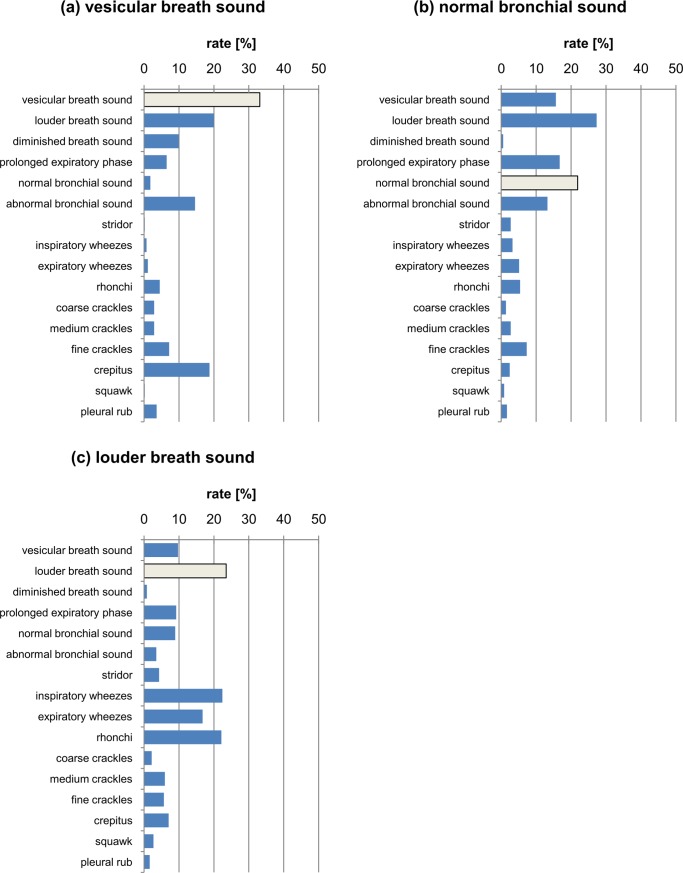
The percentage distribution of responses marked for the classes (a) vesicular breath sound; (b) normal bronchial sound; (c) louder breath sound. The light grey bar depicts the correct answer.